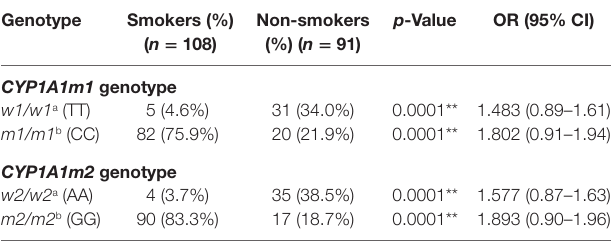
TaBle 4 | Association of smoking risk with CYP1A1 m1 and CYP1A1m2 genotype distribution among women with breast cancer (patients only).